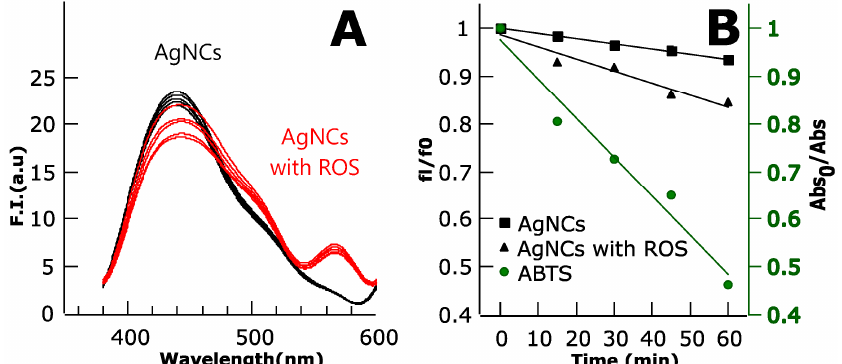
Figure 7. ( A ) Fluorescence emission spectra of the C3_cys AgNCs. Black lines represent no reactive oxygen species (ROS) control samples and red lines correspond to Rose Bengal-metal NCs samples, i.e., with oxidative stress from ROS production. ( B ) Stern–Volmer plot showing the quenching of the AgNCs fluorescence with time upon irradiation of Rose Bengal (RB), related to increased amounts of ROS. ABTS was used as a probe for ROS production; its absorbance was measured to check the formation of ROS (green spheres, absorbance in green axis).